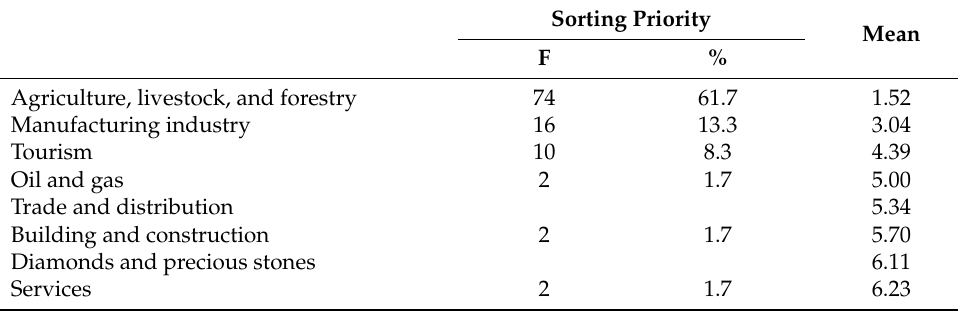
Table 9. Priority activity sectors to be developed in Angola.